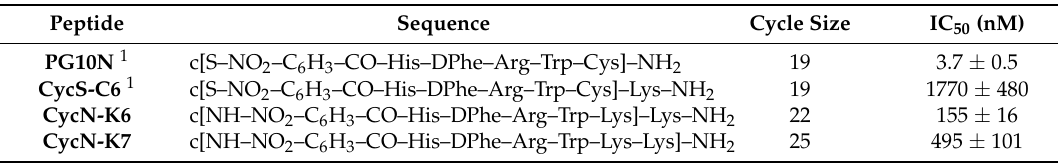
Figure 1. Structural formulas of the cyclic α -melanocyte stimulating hormone ( α -MSH) analogues CycS-C6 , CycN-K6 , and CycN-K7 . Table 1. Sequences, cycle size and MC1R binding affinities (IC 50 ) of cyclic α -MSH analogues. Peptide Sequence Cycle